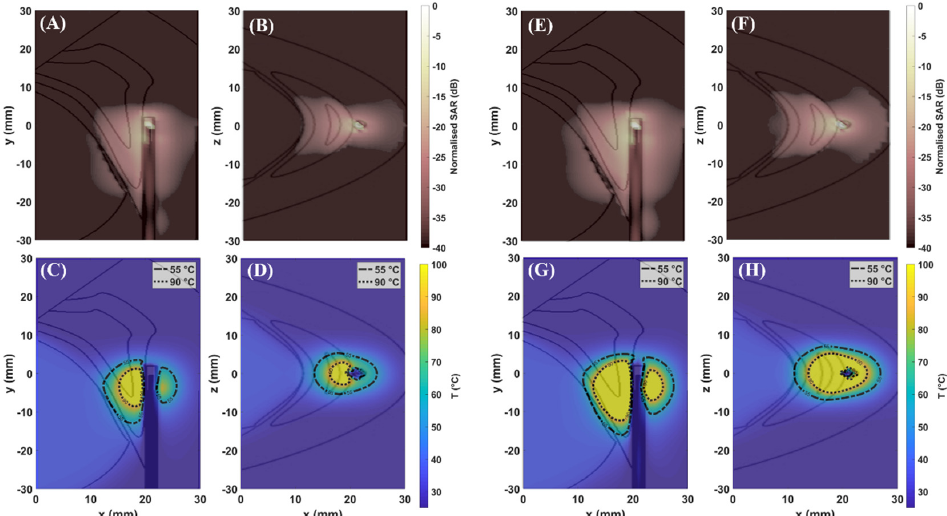
Figure 5. Maps of SAR: ( A , E ) axial plane (xy–plane); ( B , F ) coronal plane (xz–plane) and maps of temperature ( C , G ) axial plane (xy–plane); ( D , H ) coronal plane (xz–plane), obtained in the 3D model at 30 W and 60 W at 5.8 GHz. The applicator is aligned at the interface between fat and adrenal gland orientating the longitudinal axis parallel to the y-axis of the reference system (Figure 1B Ori- entation #2). Frontal plane (xy–plane) and coronal plane (xz–plane) are indicated with reference to the longitudinal axis of the antenna.